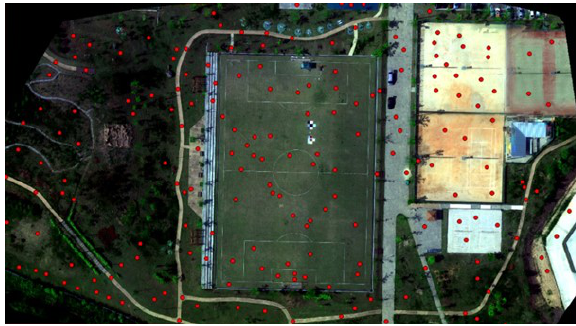
Figure 10. Distribution of validation points within the mosaicked image The RMSE of the visible (blue, green, red) bands is about 0.03, although red-edge and NIR bands show about 0.06 and 0.10, respectively. A reason of higher RMSE of red-edge and NIR bands might be cover types of study area that most of the area is composed with grass and trees. Vegetation has higher reflectance in red-edge and NIR bands than visible bands.